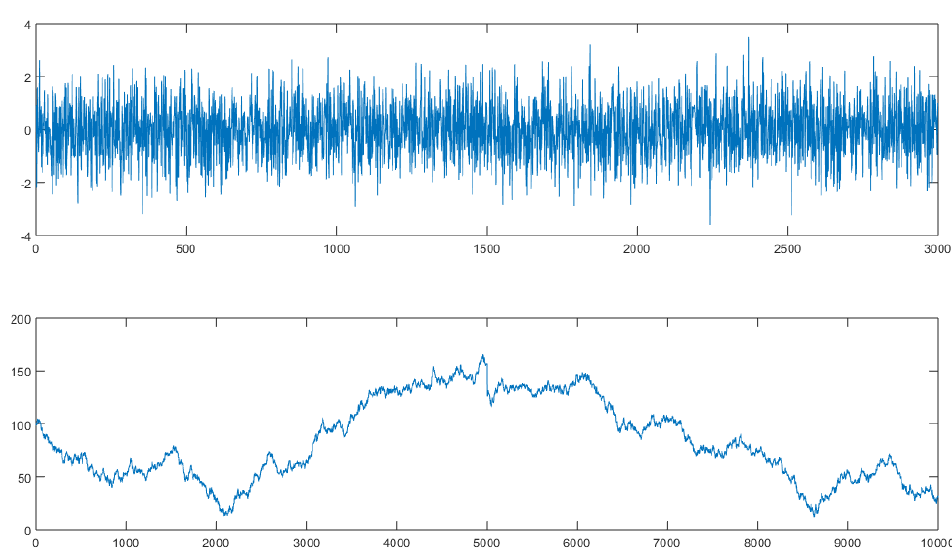
Figure 5. Simulation of a financial time series u n based on the Random Walk Hypothesis (below) using Equation (12) for N = 10,000 and a stationary zero-mean Gaussian-distributed stochastic field r n (above) for the price differences (where only the first 3000 samples are